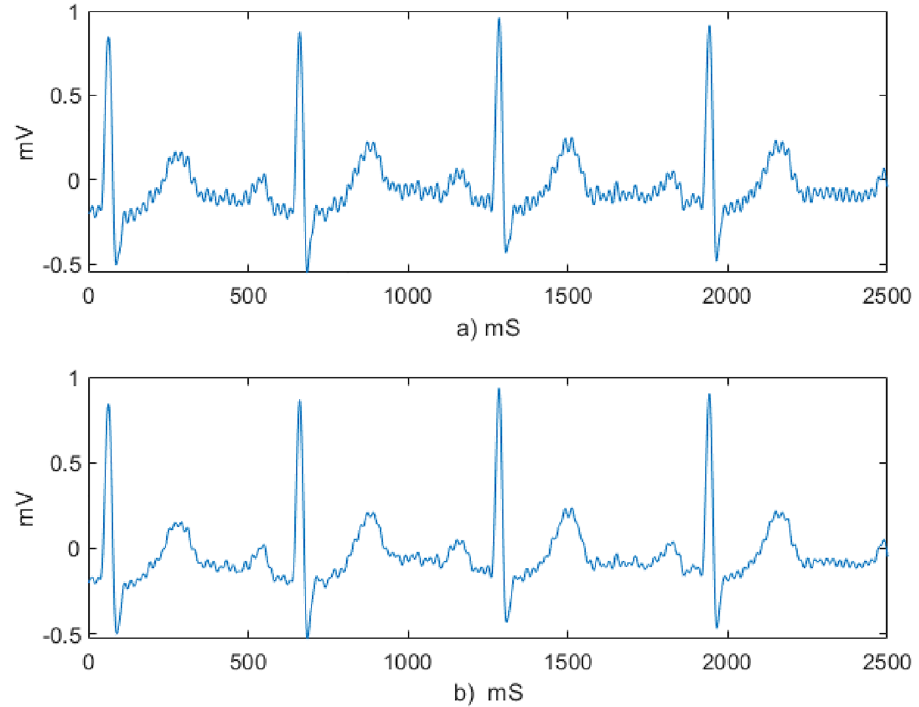
Figure 4. ECG signal denoising ( a ) sample raw ECG data of experimental group subject ( b ) the smoothed ECG signal using the Savitzky Golay filter.